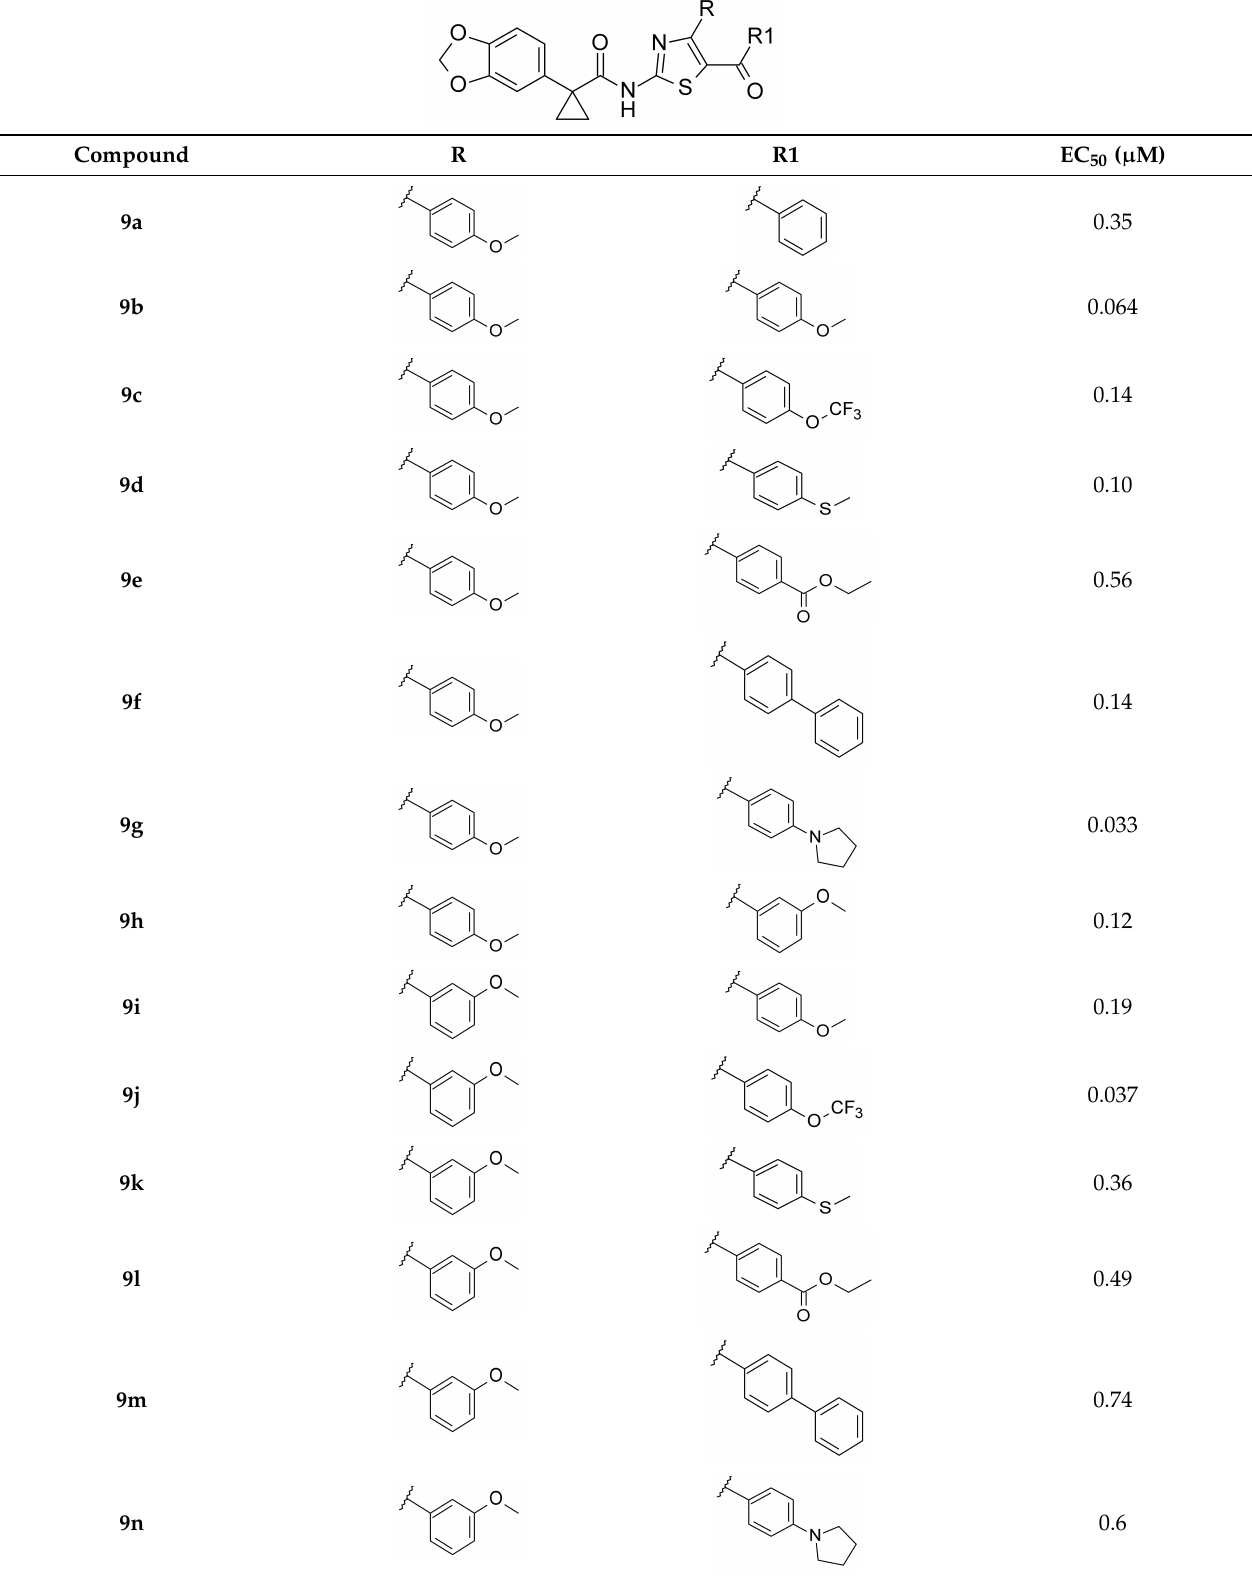
Table 2. Chemical structure and potency trends of the newly described hybrids 9a–9z as F508del CFTR